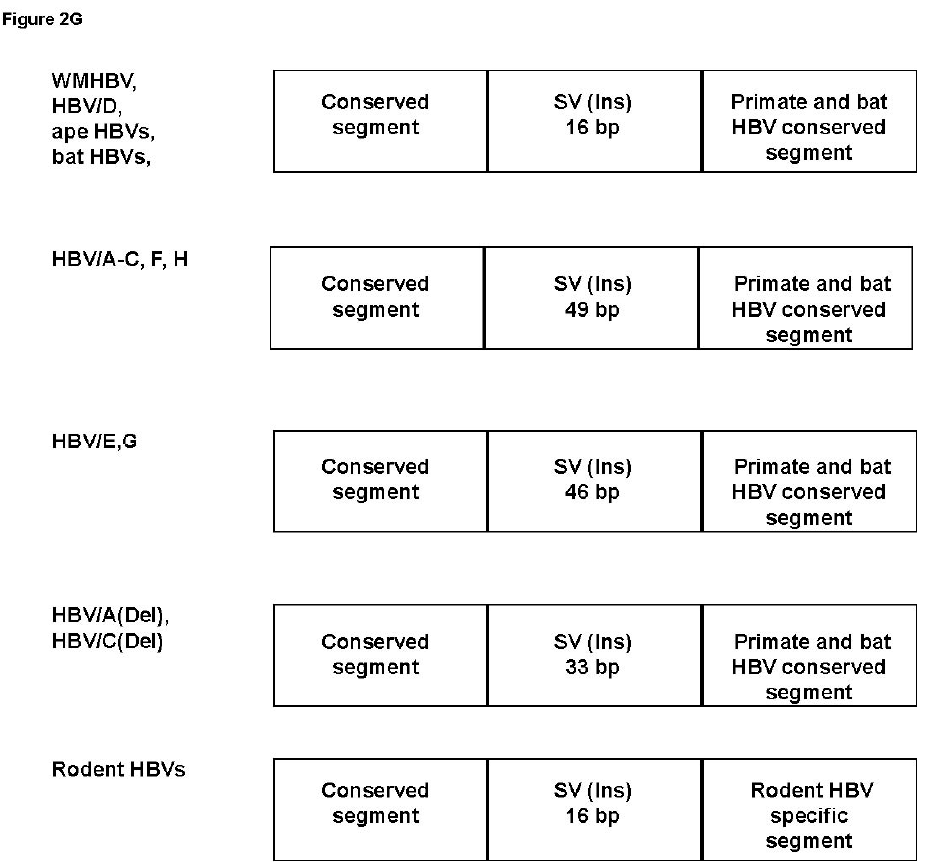
Figure 2. Analysis of structural variations (SVs) among orthohepadnaviruses. Ins, insertion. ( A ), Alignment of the Core ORF start region from nt 1895 to 1919 (WMHBV) revealed di ff erent SVs in HBV / G and TBHBV as shown in shaded rectangle. ( B ), Alignment of the Core region from nt 2318 to 2396 (WMHBV) revealed di ff erent SVs in several orthohepadnaviruses as shown in shaded rectangles. ( C ), Alignment of the pre-S1 ORF start site region from nt 2826 to 2890 (WMHBV) revealed di ff erent SVs in species with orthohepadnavirus. Since this area contains multiple segments with SVs, locations of SVs are shown as SV position 1 to 3 as shown in shaded rectangles. ( D ), The SV